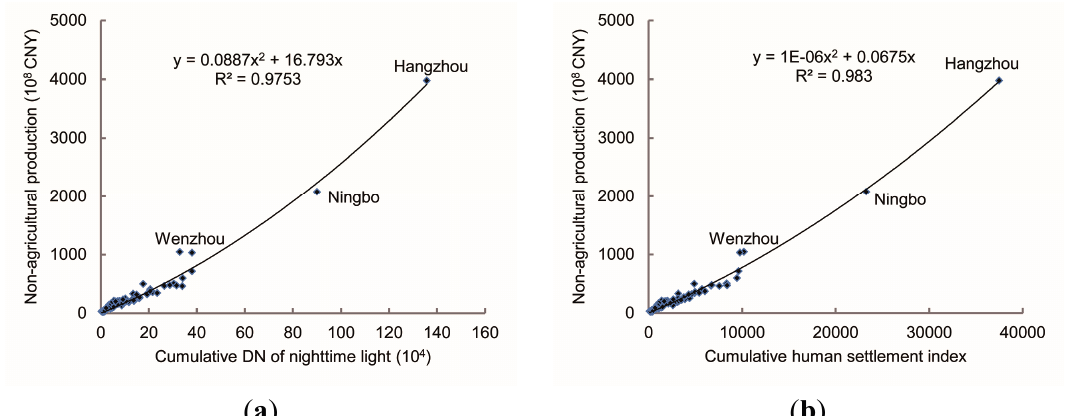
Figure 4. Scatter plots between the total non-agricultural production at the county level in Zhejiang Province and ( a ) cumulative DNs of the stable NTL and ( b ) cumulative